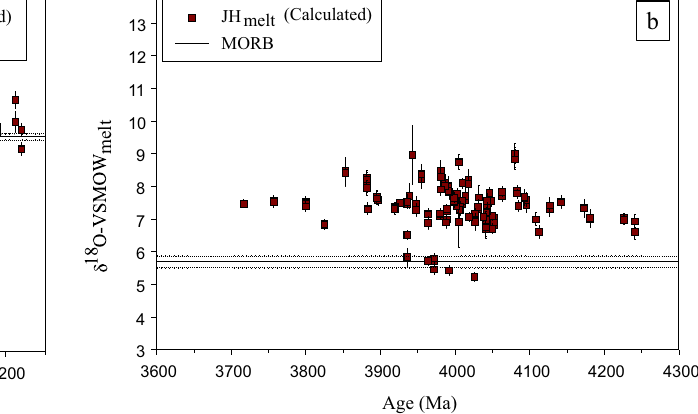
sources: Cherts 23,49 /Silici fi ed pillow basalts 49 ; TTGs 25,26 (Tonalite-Trondjhemite- Granodiorite); GMS 25 (Granite-Monzogranite-Syenite); Komatiite 26 ; MORB 61 (Mid Oceanic Ridge Basalt). Error bars on our data are internal